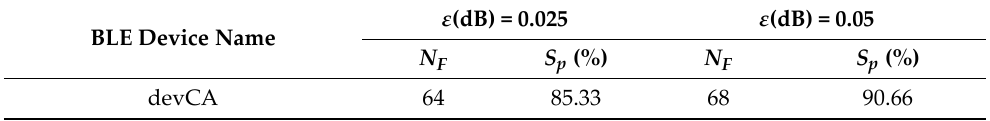
Table 5. Results of the comparison of the average PSDs of the same device transmitting two differ‑ ent